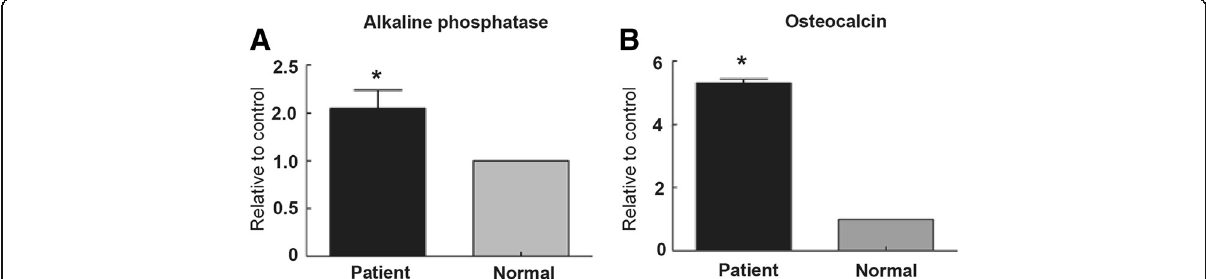
Fig. 3 Osteoblast specific genes expression levels in patient and normal orbital bone. Both osteocalcin ( a ) and alkaline phosphatase ( b ) were highly expressed in patient ’ orbital bone. * P < 0.05, compared with the